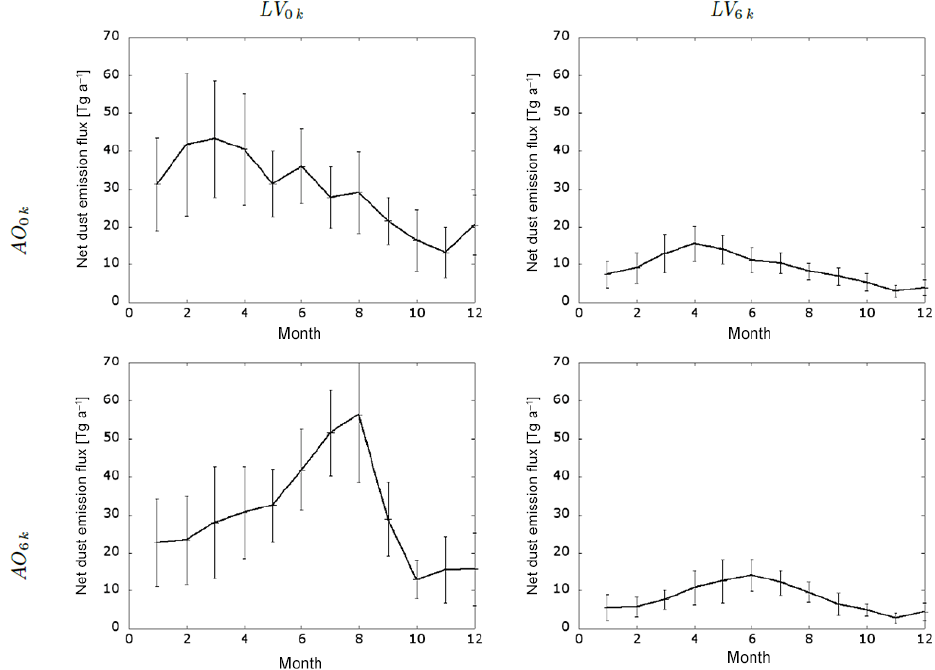
Figure A2. Mean annual cycle of simulated dust emission for altering atmosphere-ocean (AO) and land surface (LV) conditions in North Africa (17 ◦ W–40 ◦ E; 10–30 ◦